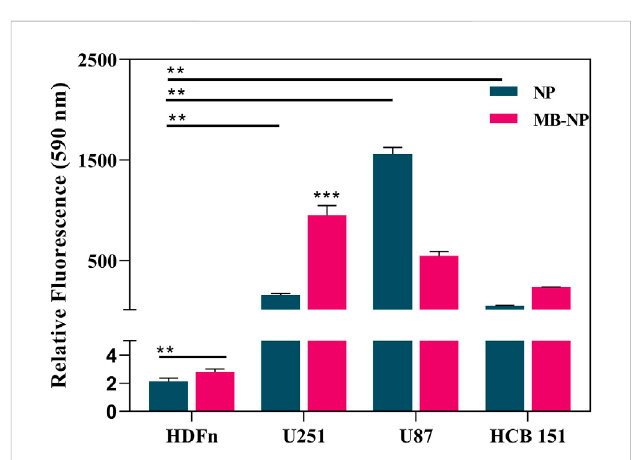
FIGURE 8 Evaluation of homotypic targeting ability of NP-MB. Cell internalization pro fi le of NP and MB-NP in non-tumoral HDFn and different glioma cell lines. HDFn, U251, U87, and HCB 151 cells were incubated for 8 h with DiO-labeled NP and MB-NP and processed for fl ow cytometry analysis, by which the fl uorescent intensities of both nanostructures were acquired. The results express the geometric mean of the fl uorescence intensity divided by the average of a blank cell. Data represent the mean ± SD of three independent replicates (n =